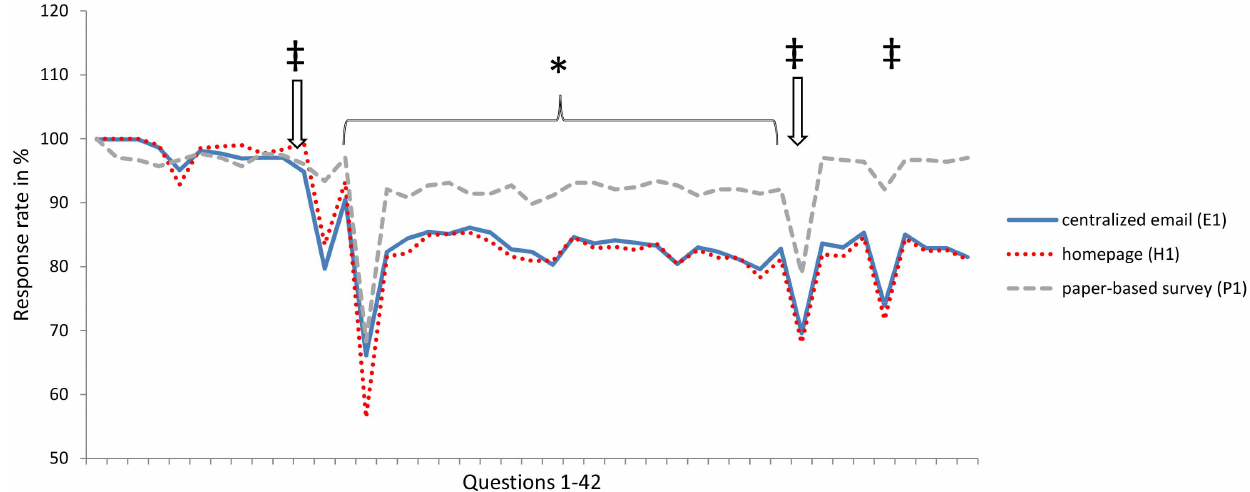
Figure 3. Responses to nonscaled ` and Likert-scaled* questions for the three survey methods (E 1 , H 1 , and P 1 ).